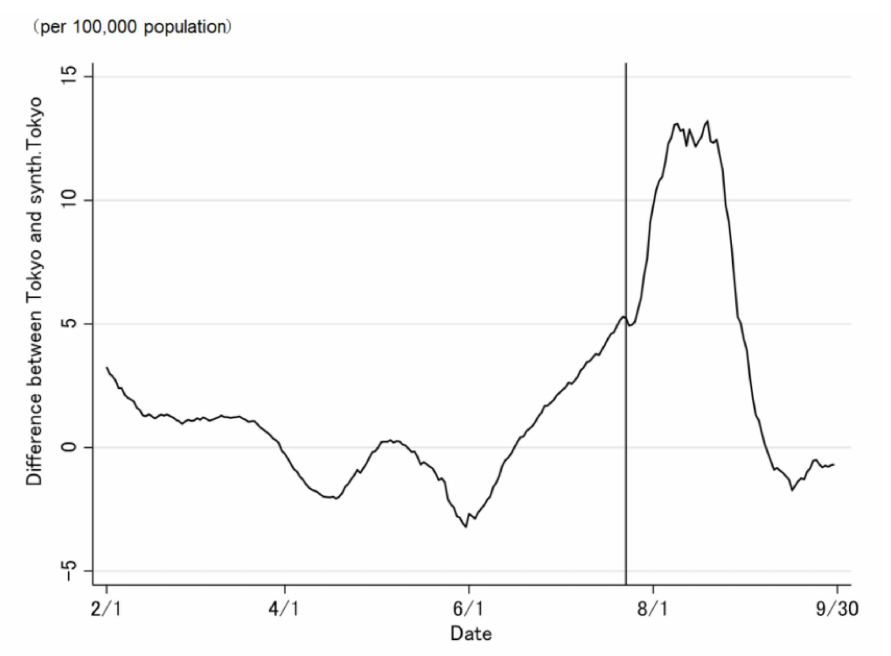
Figure 3. Difference in the daily number of newly confirmed COVID-19 cases between Tokyo and synthetic Tokyo, estimated using synthetic control